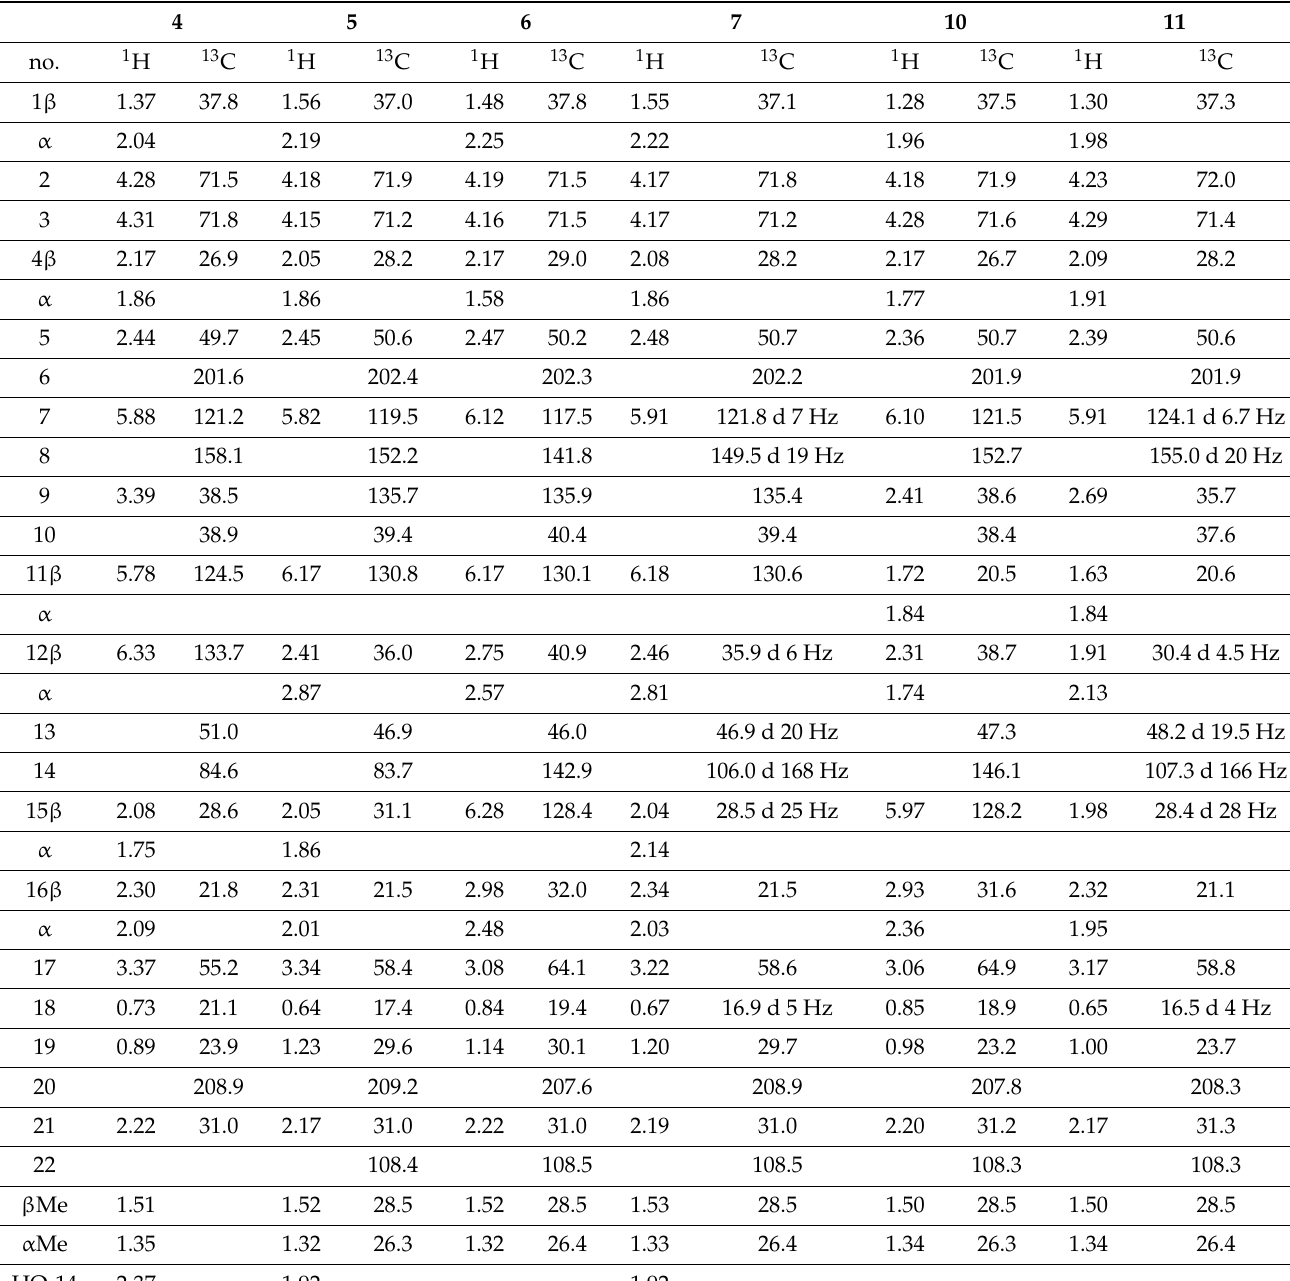
Table 1. 1 H and 13 C chemical shifts and J C,F coupling constants of compounds 4 – 7 , 10 , and 11 in CDCl 3